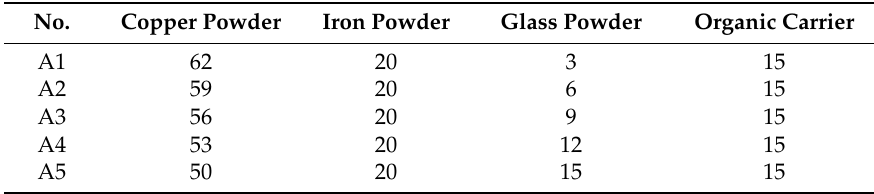
Figure 1. Model of the composite ceramic panel ( a ) with a single magnetic interlayer and ( b ) with a three-layer gradient. Table 1. Constituents of the magnetic slurry (wt%).